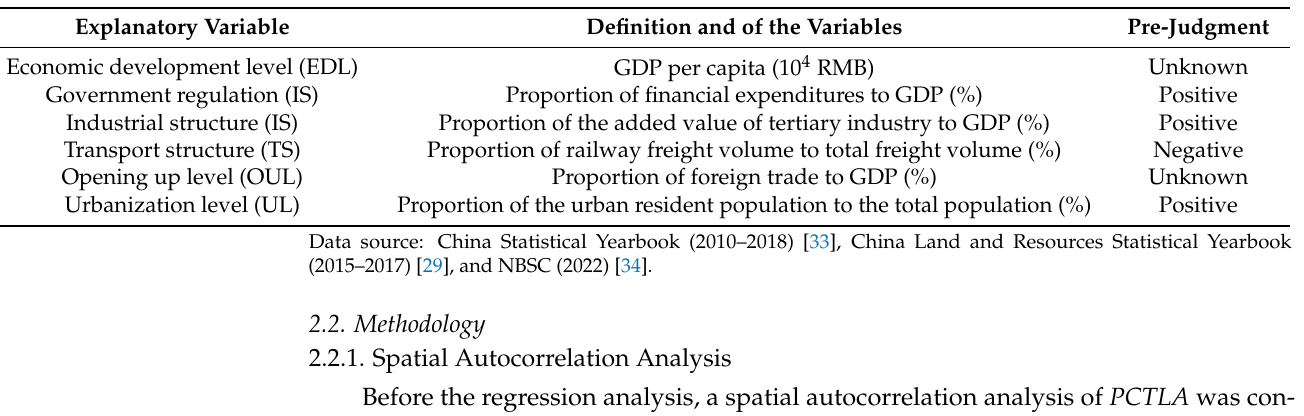
Table 1. Influencing